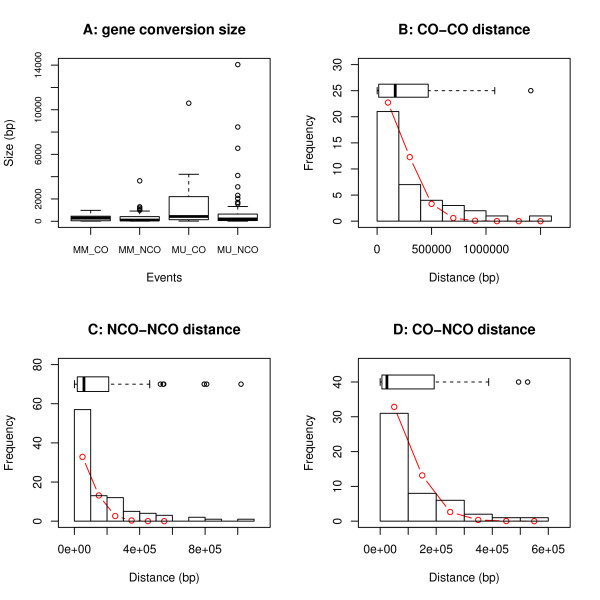
Distributions of CO and NCO sizes (A), distance between COs (B), distance between NCOs (C), and distance between COs and NCOs (D). The sizes of gene conversion tracks associated with COs and NCOs were not significantly different (A). Sizes were defined by the closest markers where the defined allele changes were observed (Additional file 14: Figure S7, materials and methods). The ends of the whiskers represent 1.5 interquartile range of the lower/upper quartile. The distributions of all three types of distance fit well with Poisson distributions (B, C, D). The red circles and lines represent expected Poisson distributions that fit to the datasets, as determined by the method of least squares. The R square values were 0.93295, 0.93026, and 0.95587, respectively. Distance values were calculated based on the start positions of consecutive breakpoints.